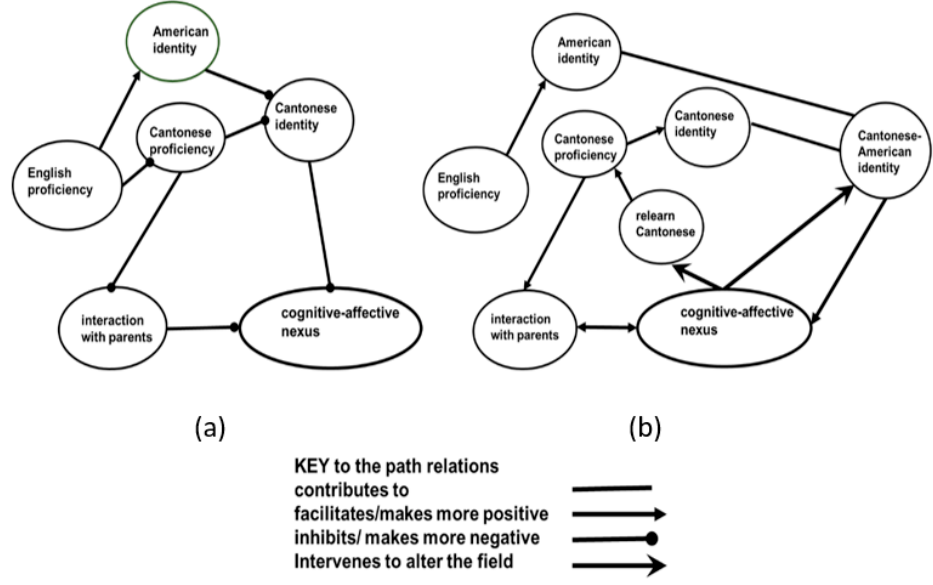
Figure 1. The Phenomenal Fields of an Illustrative Case: ( a ) before interventions, ( b ) after.